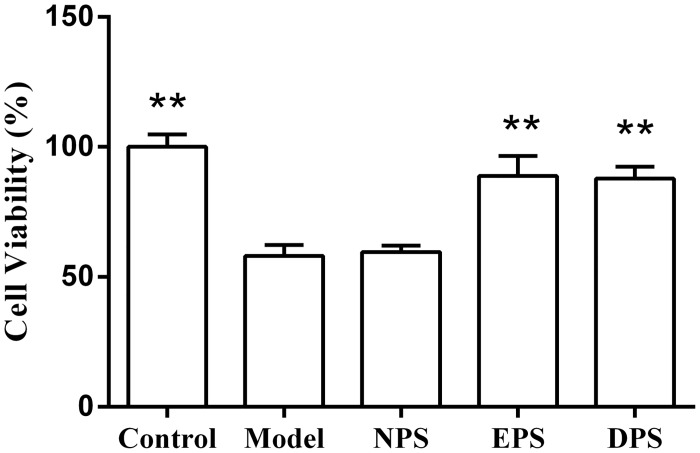
Rat LIPC sera increased the cells’ viability of H2O2-injured HUVECs.HUVECs were pretreated with 5% different sera for 12 h and followed by 2 h incubation with 1 mMH2O2. Cells’ viability was measured by MTT assay and expressed as the ratio of optical density (OD) with OD value of the control as 100%. The data (mean ± SEM) were obtained from at least three independent experiments, **P < 0.01 vs model. Control: cultured with normal medium without any intervention throughout the experiment. Model: cultured with normal medium for 12 h and then incubated with 1mM H2O2 for 2 h. NPS, EPS and DPS: cultured with normal medium containing either 5% NPS (serum derived from rats after sham LIPC), 5% EPS (serum derived from rats 20 min after LIPC) or 5% DPS (serum derived from rats 24 h after LIPC) respectively for 12 h and followed by 2 h incubation with 1mM H2O2. The figure legends are same in following figures unless illustrated elsewhere.